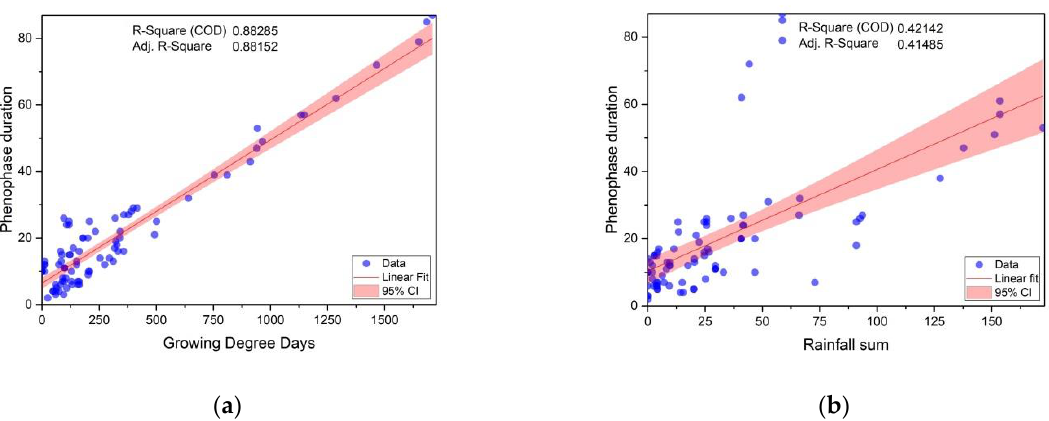
Figure 9. Linear fitting model for Agastache : ( a ) relationship between phenophase duration and growing degree days; ( b ) relationship between phenophase duration and rainfall sum per phenophase; for the regression coefficient, the phenophase duration is the dependent variable; COD — coefficient of determination, Adj. — adjusted.